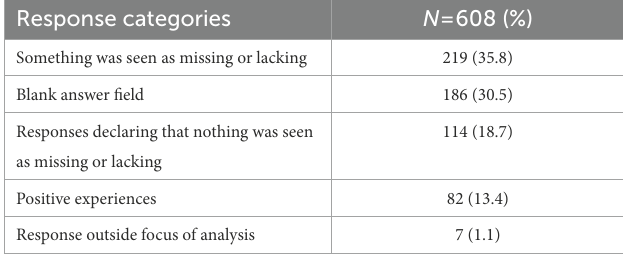
TABLE 1 Overview of response categories and frequencies of